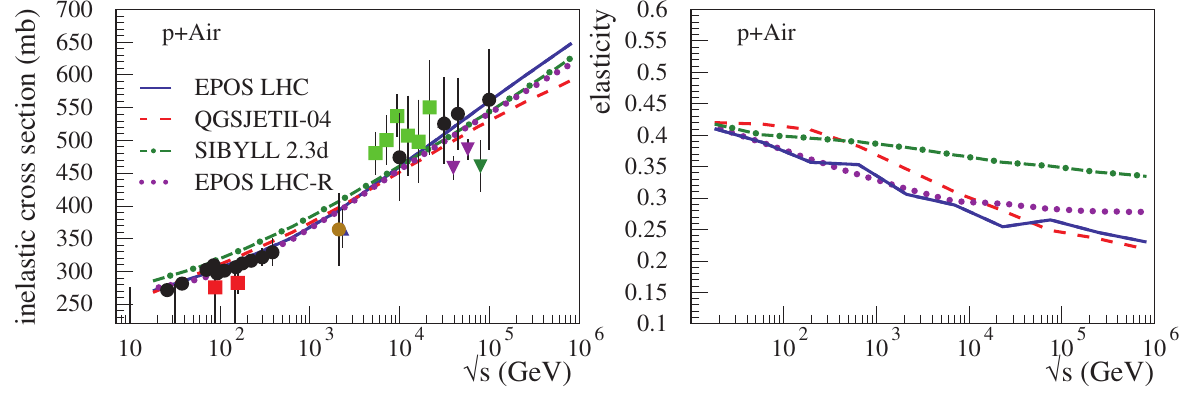
Figure 3. Inelastic cross-section (left-hand side) and elasticity (energy fraction of the leading particle) (right-hand side) for p-air interactions as a function of center of mass energy. Simulations are done with E pos LHC-R (dotted line), E pos LHC (full line), QGSJ et II.04 (dashed line), and S ibyll 2.3d (dash-dotted line). Points are data from [25].